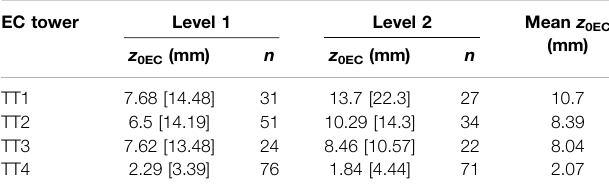
TABLE 5 | Summary of z 0EC (mm) from EC towers. Mean z 0EC for the entire measurement duration for both levels at each tower is shown with standard deviation (mm) in square brackets, including overall mean. n is the number of values that fi t the quality control criteria. EC